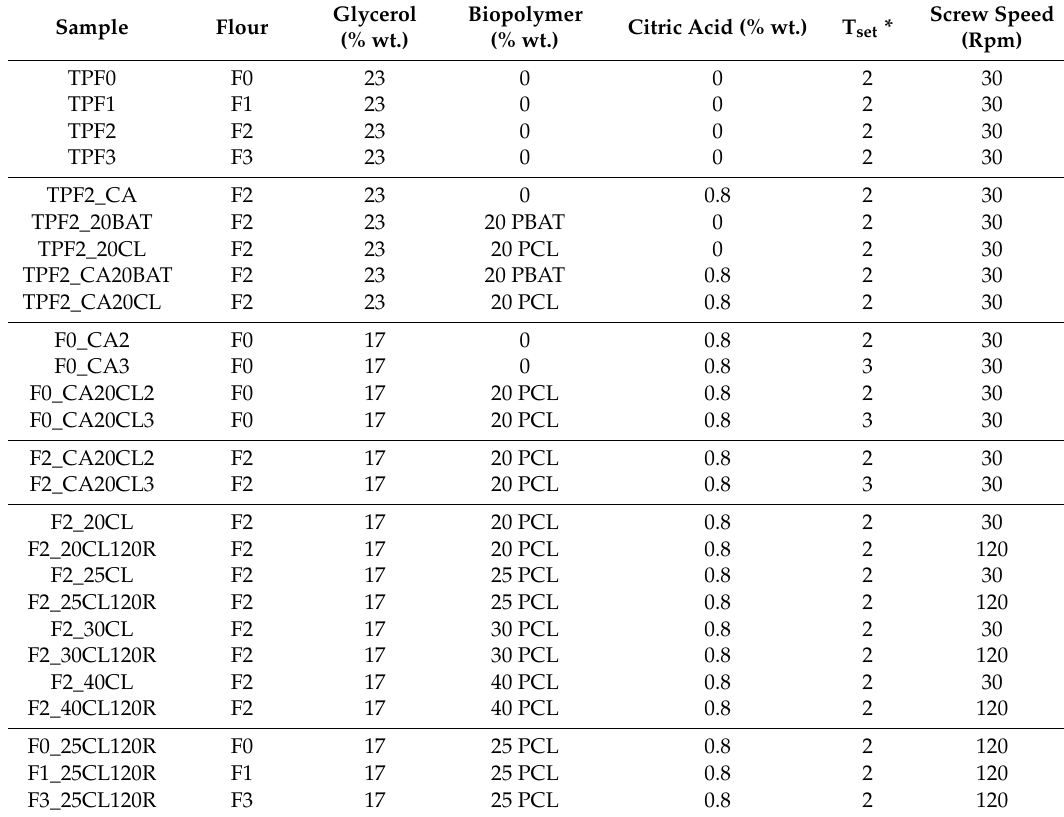
Table 2. Samples produced: Main constituents and processing